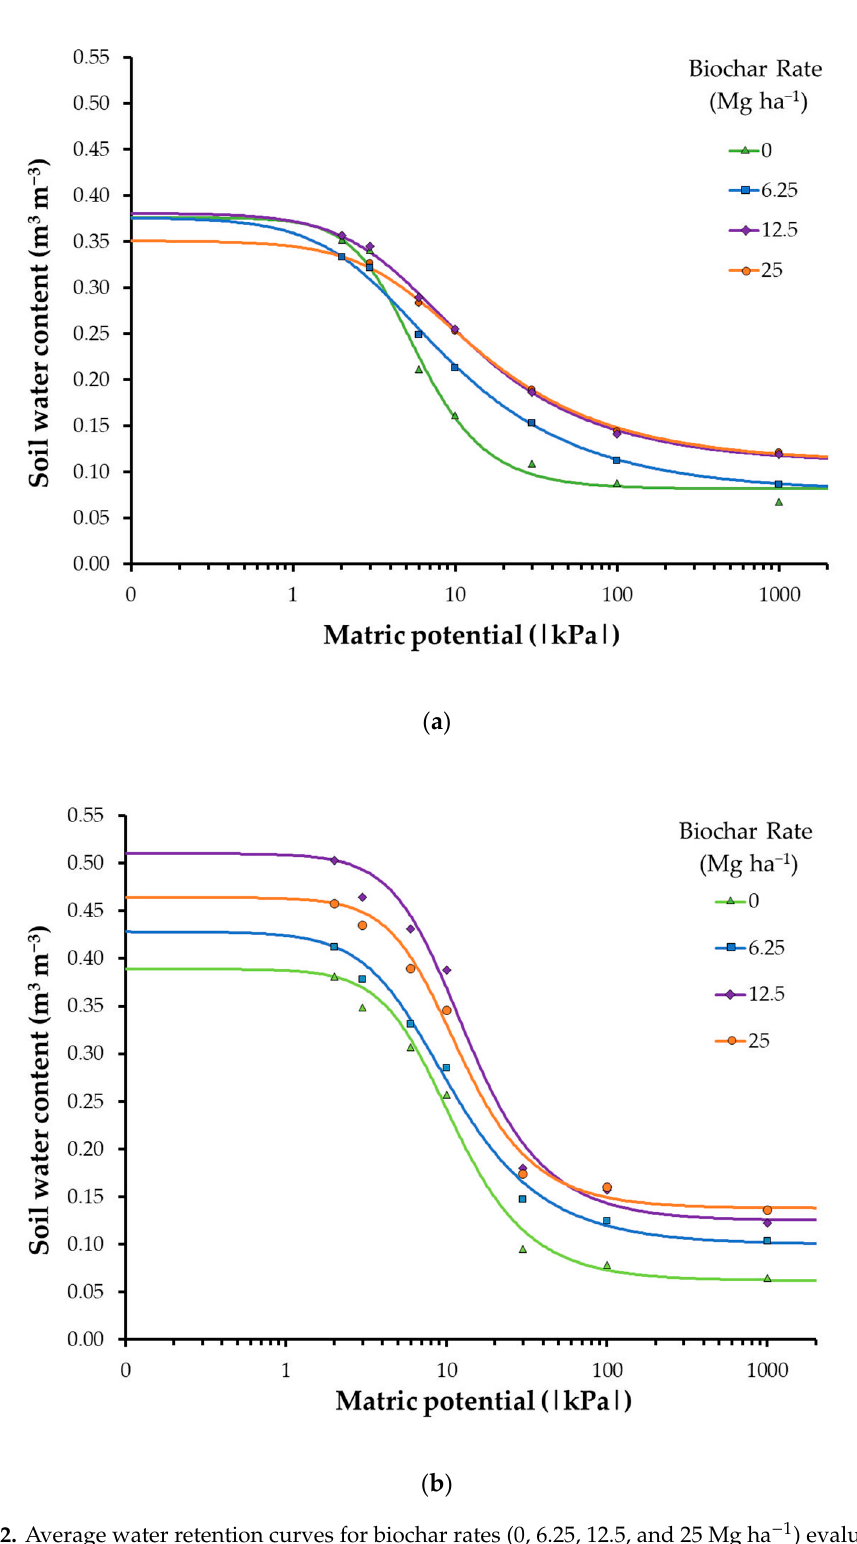
Figure 2. Average water retention curves for biochar rates (0, 6.25, 12.5, and 25 Mg ha − 1 ) evaluated at ( a ) 50 days and ( b ) 150 days after incorporation in soil. n = 4.